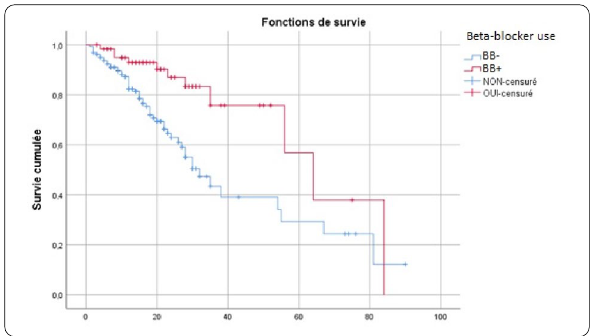
Figure 1: Kaplan–Meier survival curves (6 month mortality) according to beta-blockers use